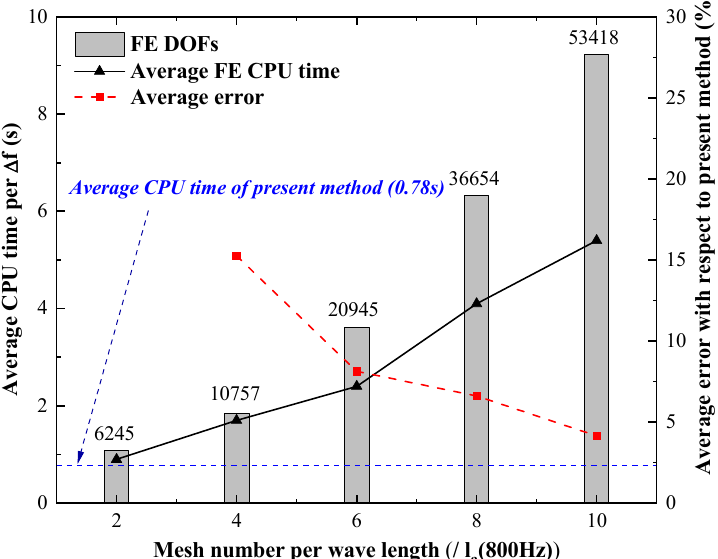
Figure 14. The calculation time and relative error (with respect to the present method) of conven- tional FEM.